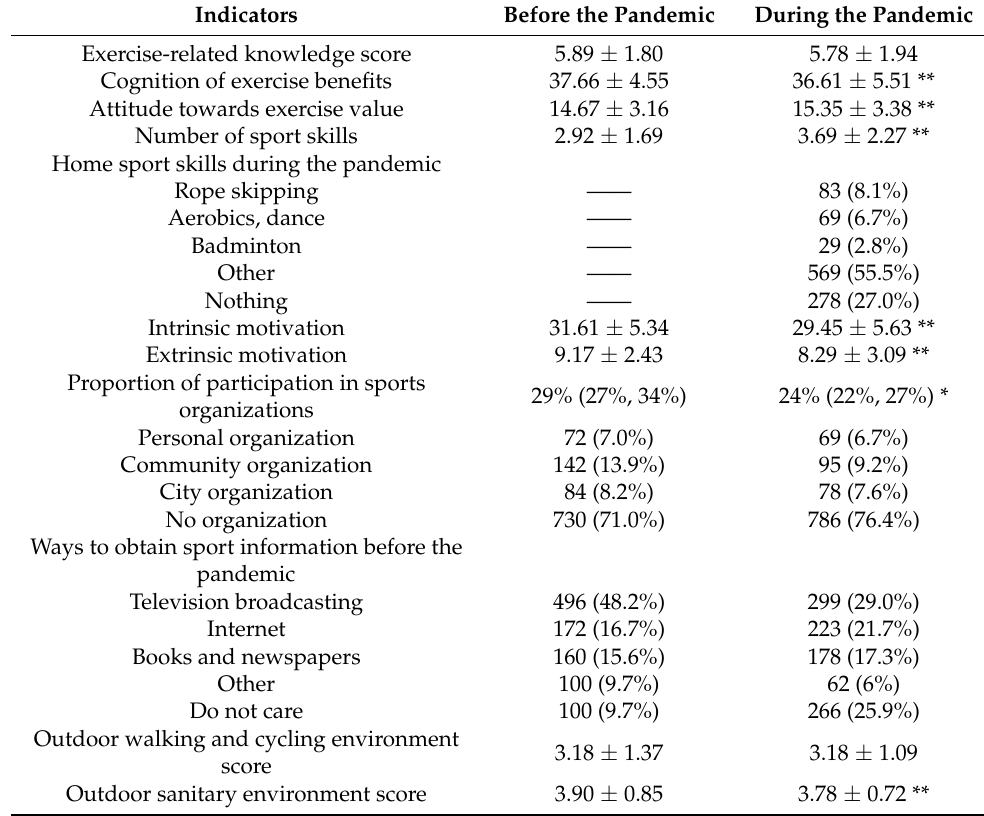
Table 4. Changes in exercise-related indicators before and during the pandemic. Indicators Before the Pandemic During the